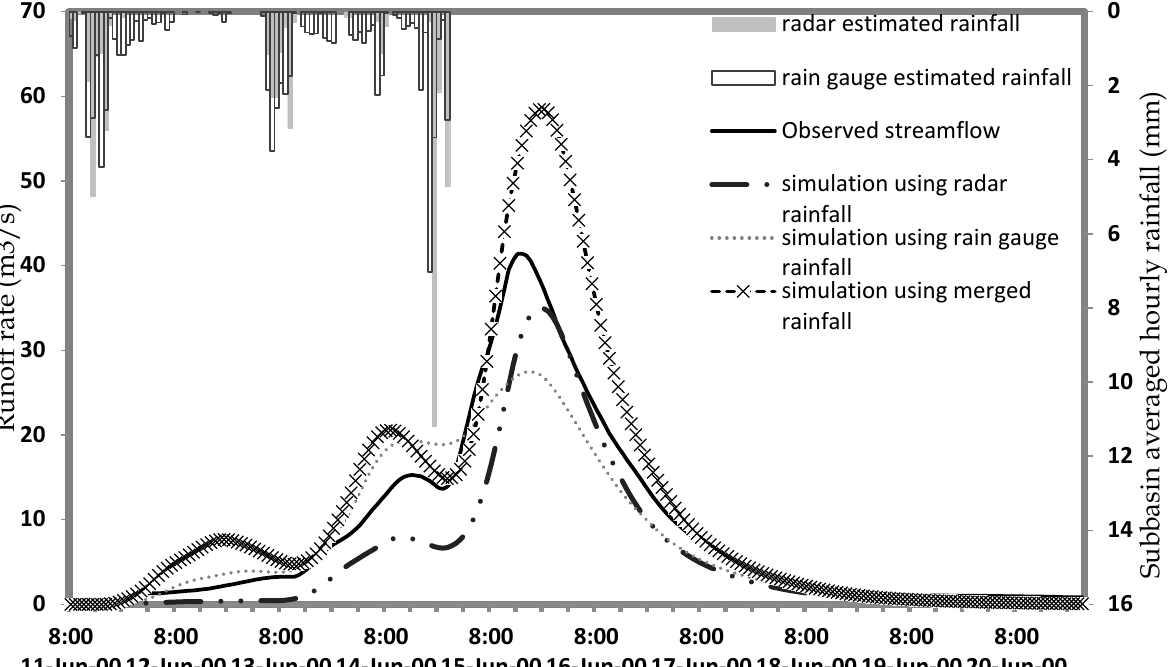
Figure 19. Comparison of estimated and observed hydrographs using different rainfall estimates for the 11 June 2000 event with Green and Ampt modeling option.